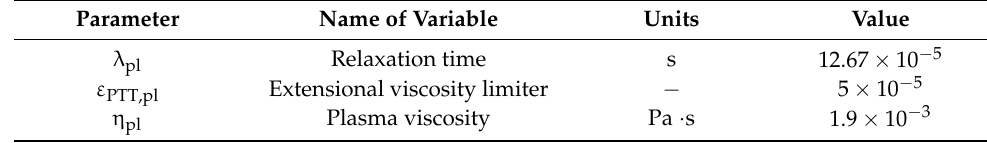
Table 3. Parameters exported by the non-linear fitting of the linear-PTT model to plasma data [60]. Parameter Name of Variable Units Value λ pl Relaxation